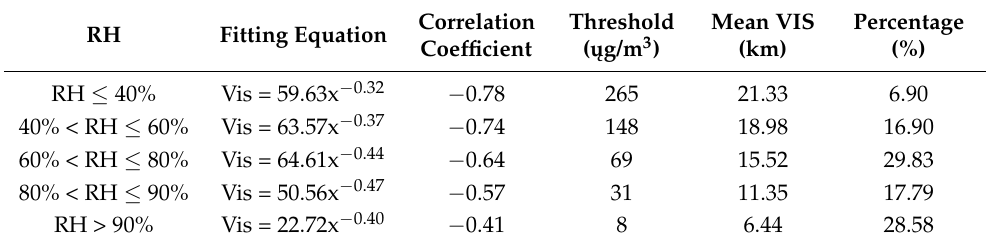
Figure 7. The relation between the visibility and PM 2.5 concentration corresponding to different relative humidity ranges. Table 2. Quantitative relation between the visibility and PM 2.5 corresponding to different relative humidity ranges.